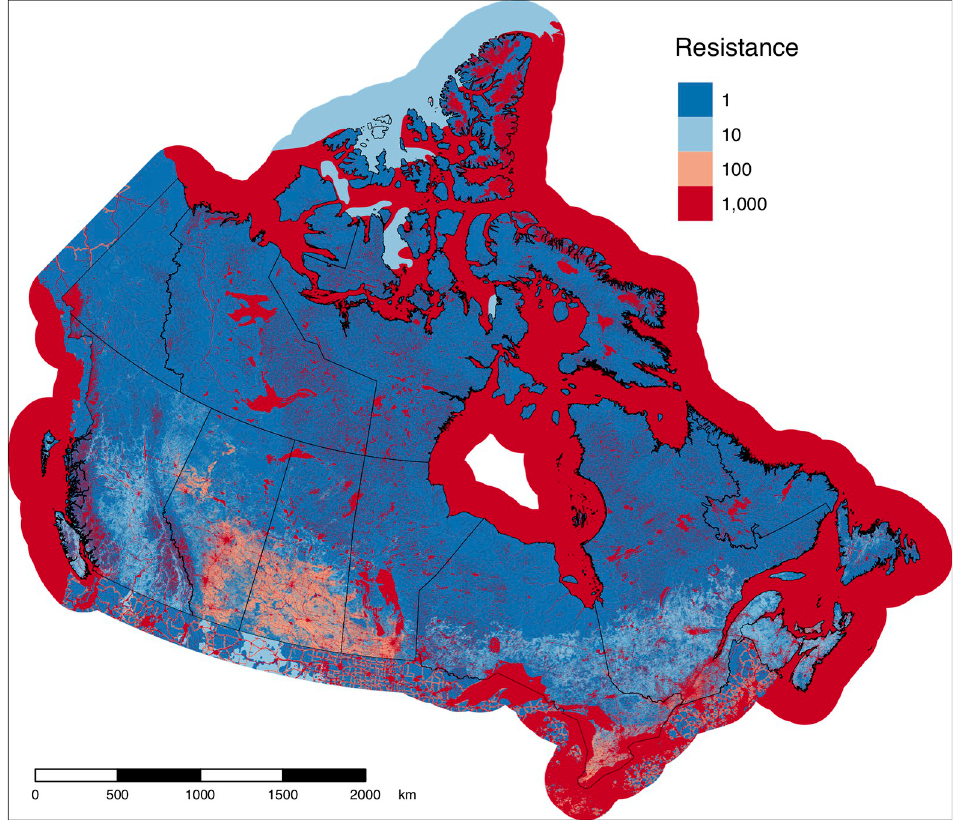
Fig 1. Movement cost layer for Canada. Four movement costs, reflecting the increasing cost of (or resistance to) movement of terrestrial, non-volant fauna across various land cover types, were used to construct the layer. Areas with intense human use, along with large lakes and rivers and steep slopes, have higher movement costs than natural areas. Contains information licensed under the Open Government Licence–Canada.